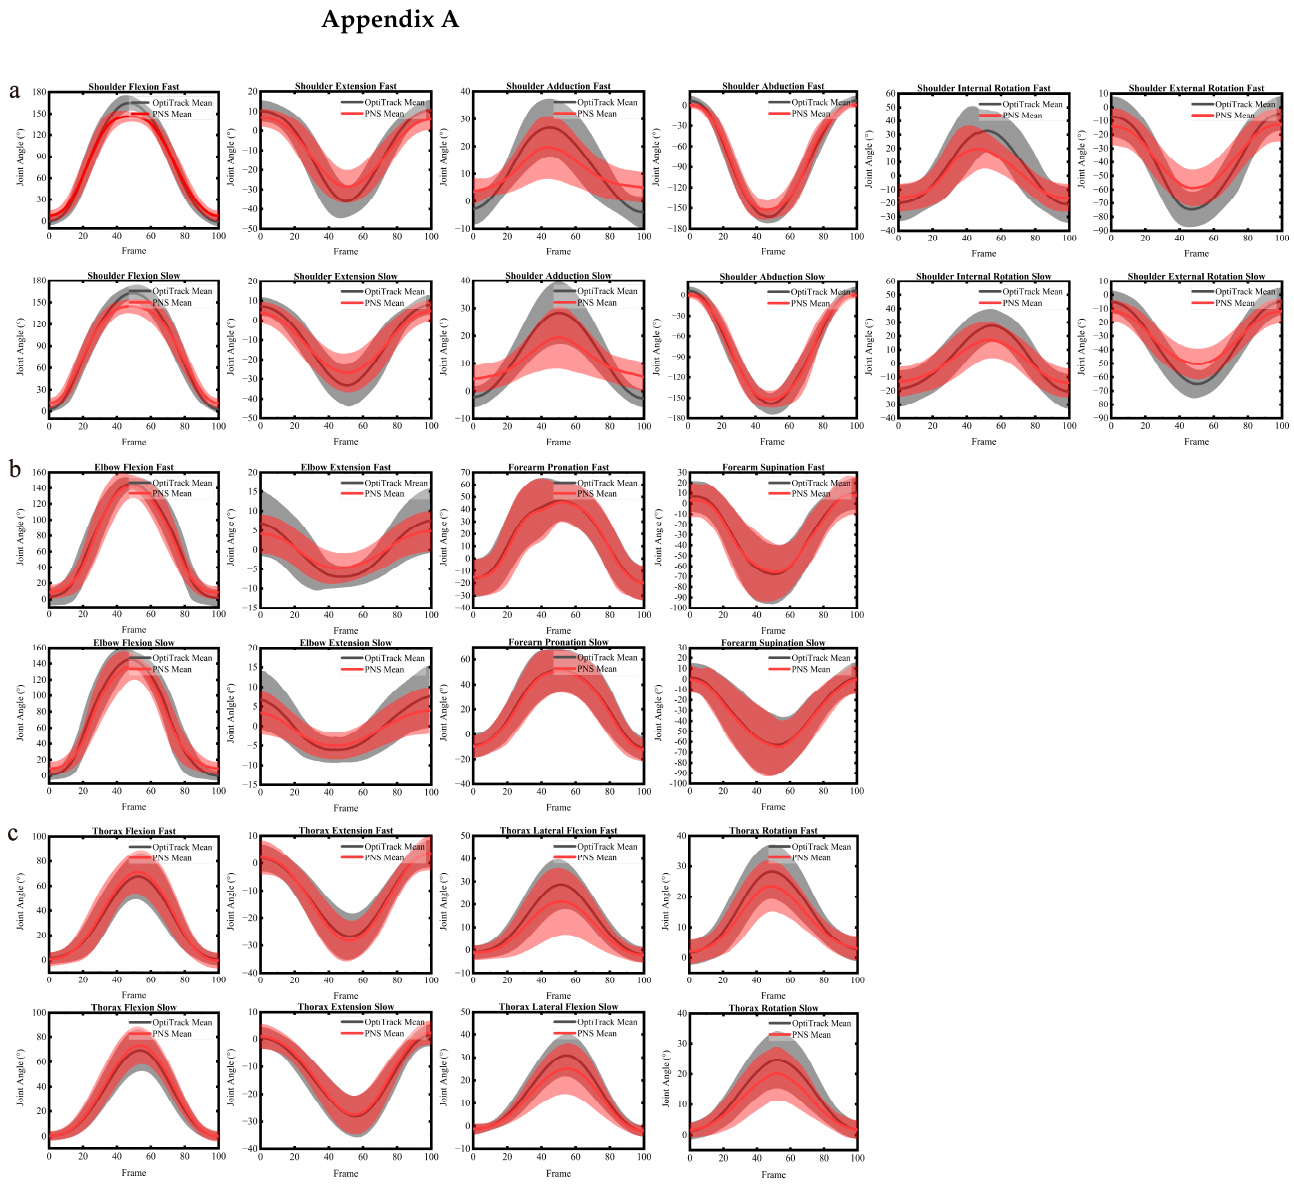
Figure A1. Comparison of the PNS and OptiTrack’s mean angular curves during simple tasks. ( a – c ) The mean angular curves of the shoulder ( a ), elbow ( b ), and trunk ( c ). The thick solid lines repre- sents the mean angular curve for the PNS (red) and OptitTrack (black), and the shadow area repre- sents standard deviations from the mean angular curve.